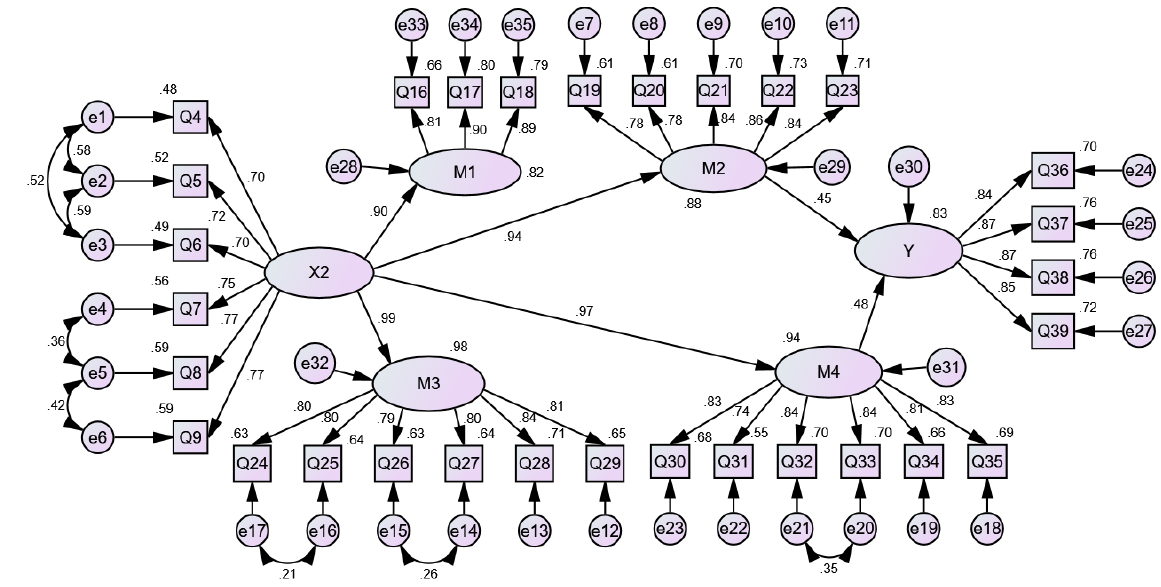
Figure 3. A revised model of the influence mechanism of institutional factors on the happiness of urban returnees.